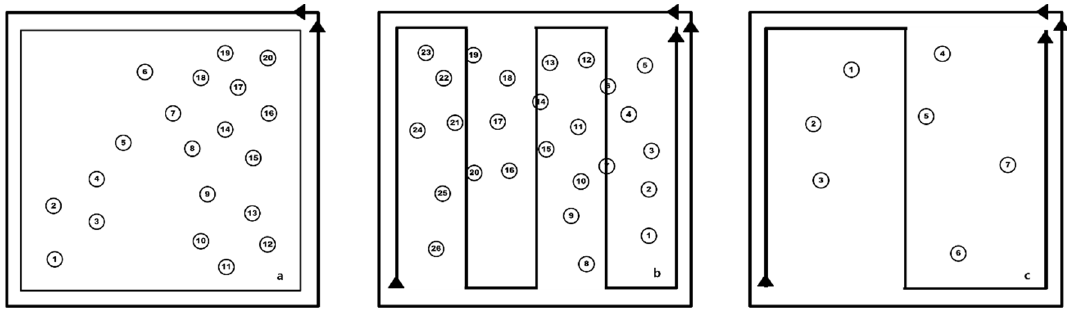
Figure 4. Data collection using BPLS ( a ) Pattern 1, ( b ) Pattern 2, and ( c ) Pattern